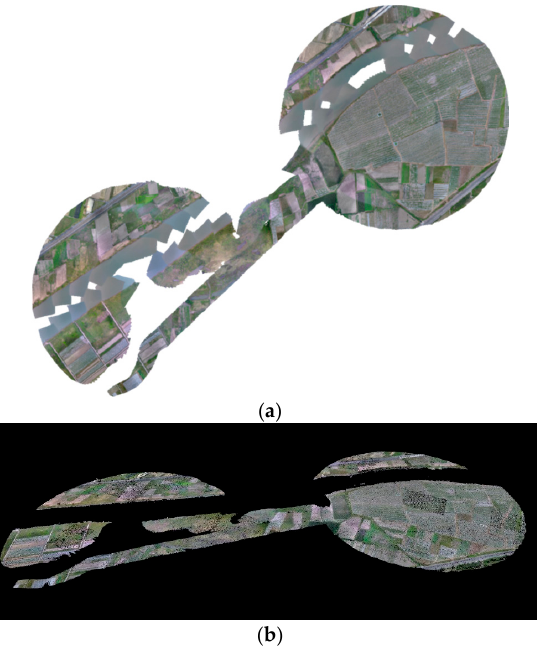
Figure 26. ( a ) Orthomosaic model of the testing area and ( b ) point clouds of the search area.